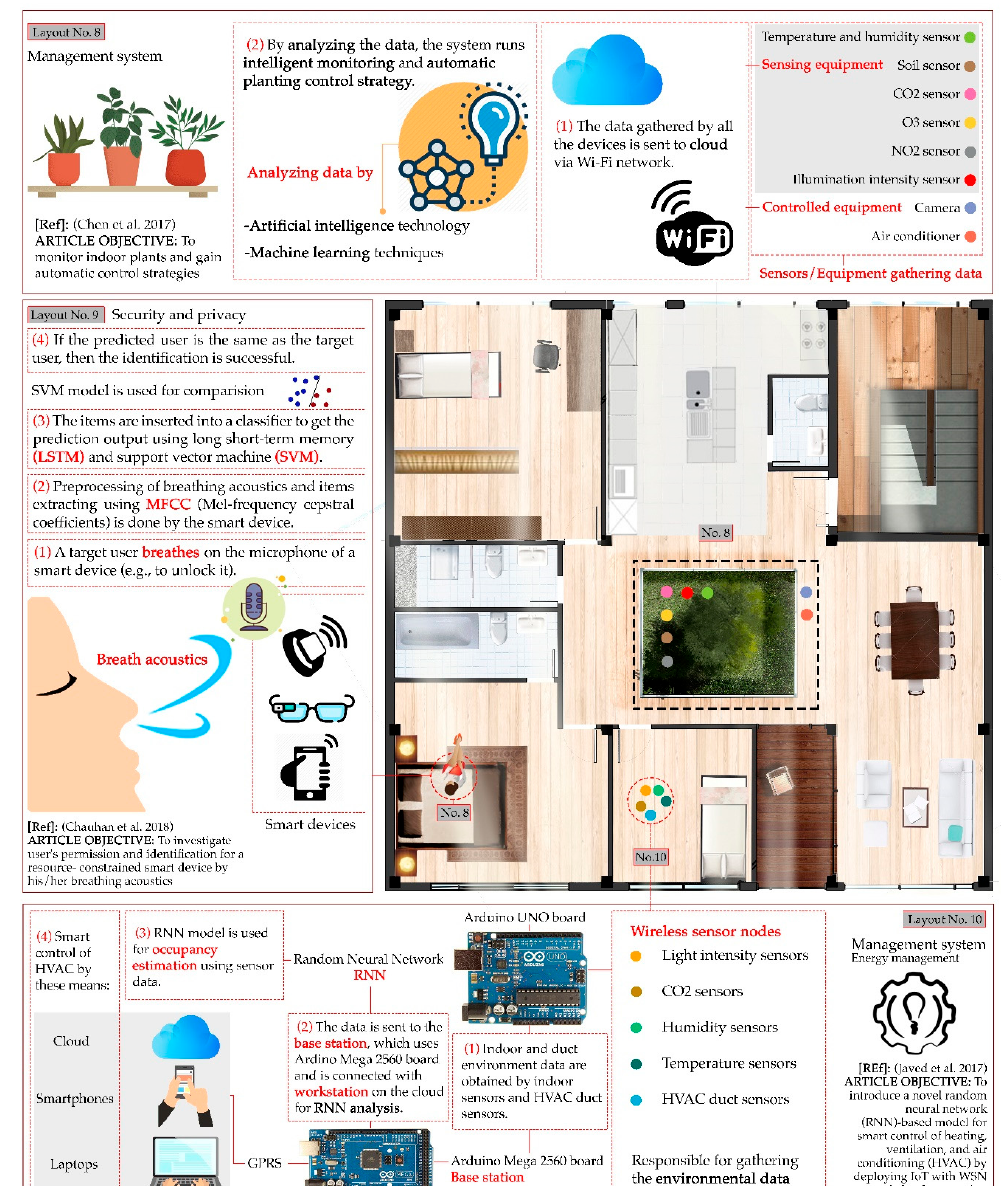
Figure 10. A typical plan of a smart home, including three layouts and a number of sensors for enhancing the living environment. Note: (i) a system able to monitor indoor plants and gain automatic control strategies [ 79 ] that are visualized in layout number 8 by authors, (ii) a system using users’ breathing acoustics for getting permission and identification in a smart home [ 80 ] that is visualized in layout number 9 by authors, and (iii) a smart system for controlling heating, ventilation, and air conditioning by a novel random neural network model [44] that is visualized in layout number 10 by authors. The location of sensors is schematically shown in the figure, and they can be